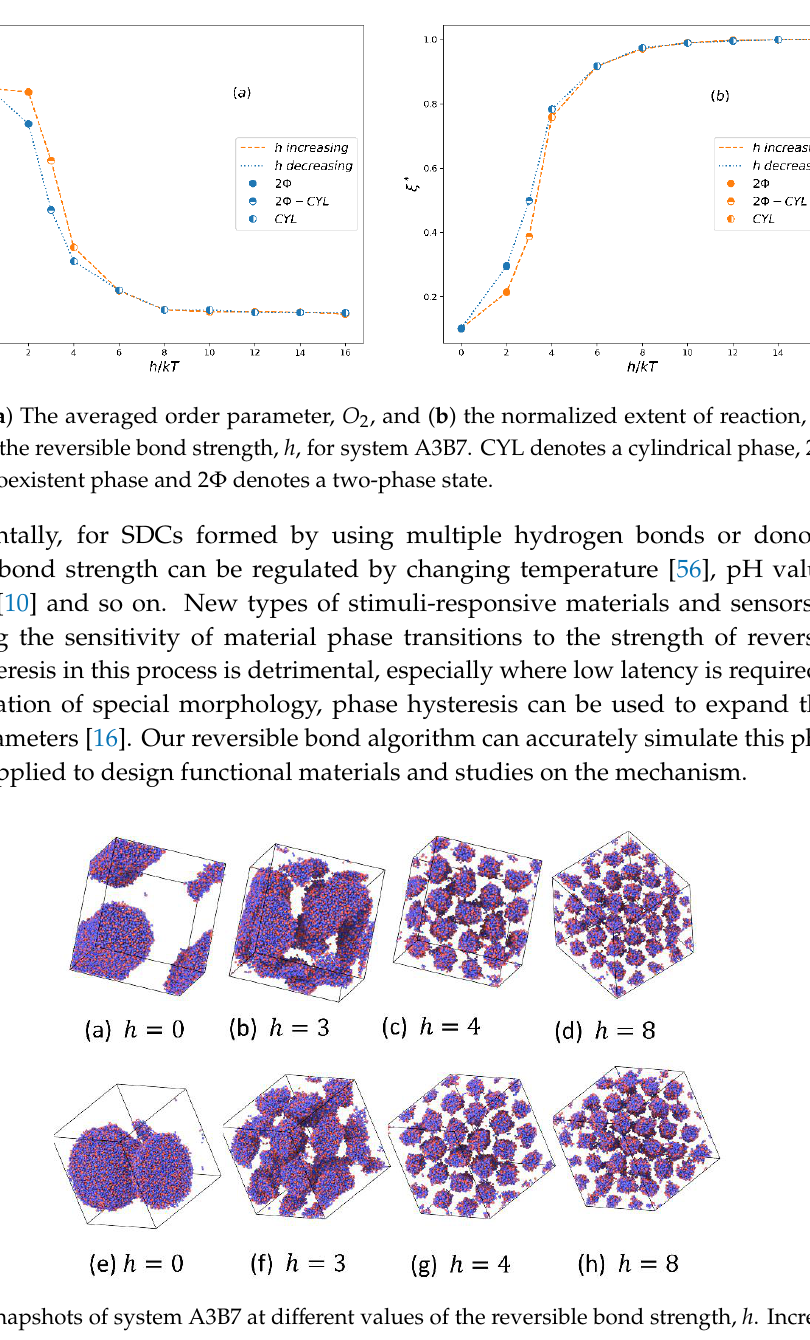
Figure 5. Snapshots of system A5B5 at different values of the reversible bond strength, ℎ . Increasing ℎ process: ( a – d ); decreasing ℎ process: ( e – h ). Red color denotes reactive A particles and blue color